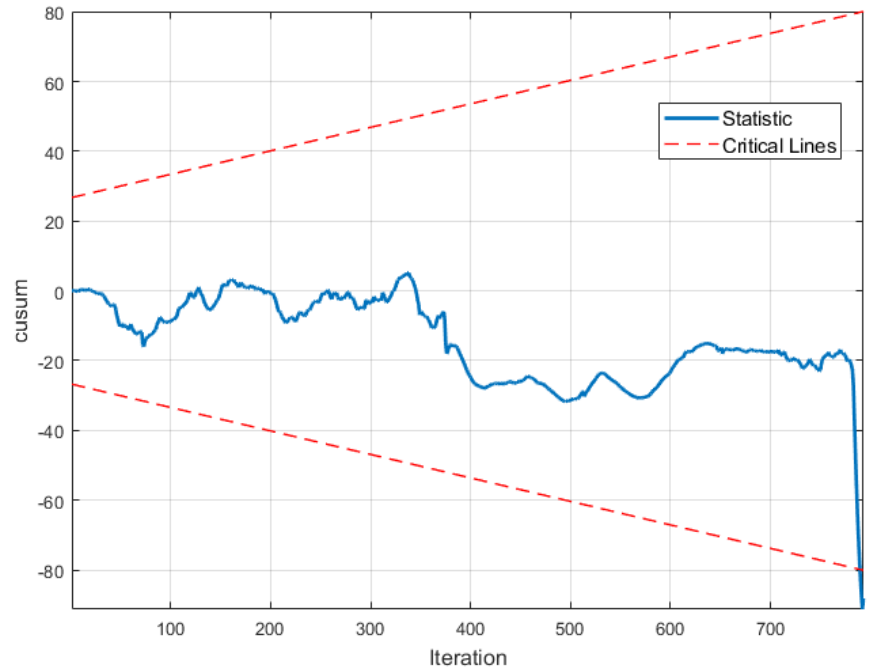
Figure 10. Monitoring and diagnosis results of the gearbox fault F2 using CUSUM test statistics.